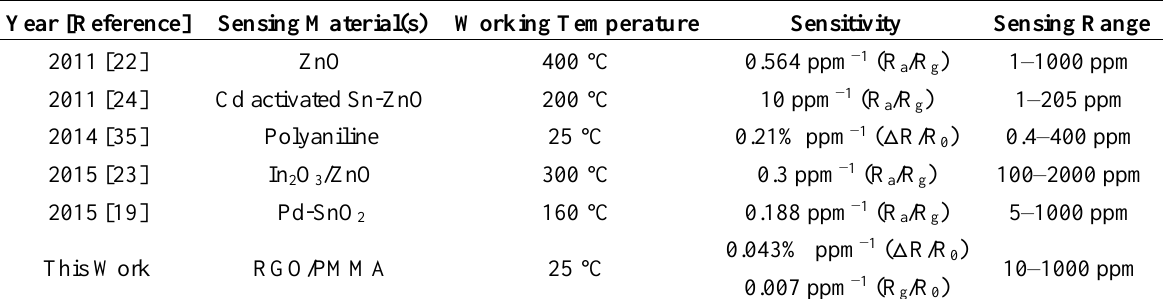
Table 1. Performance of some formaldehyde gas sensors.